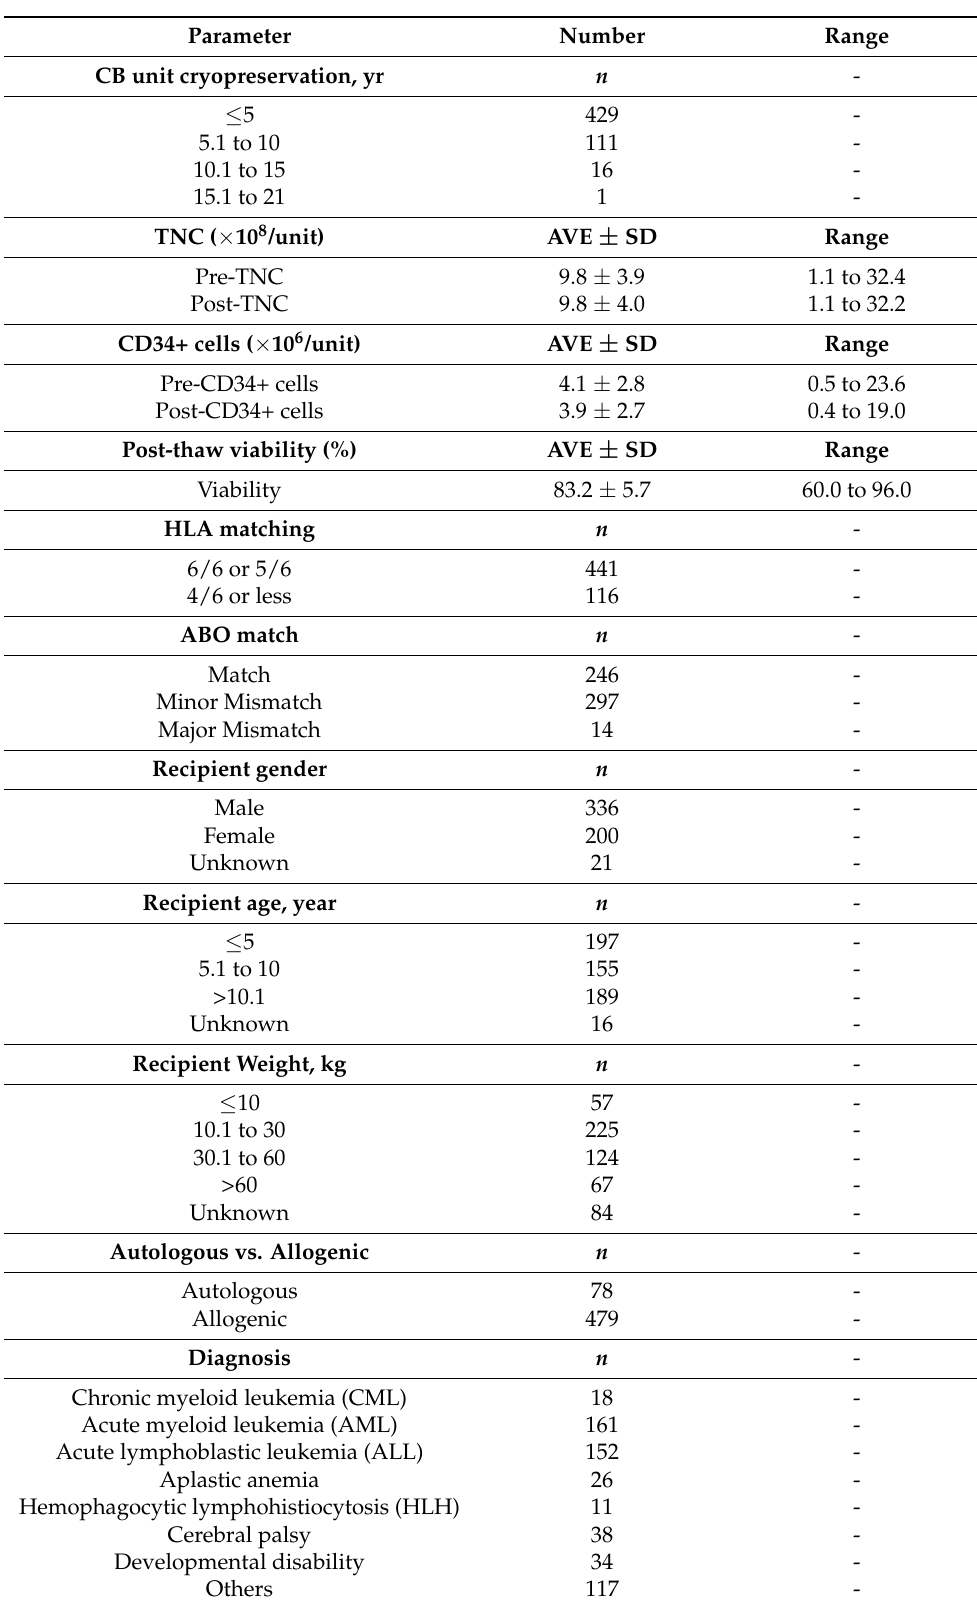
Table 3. Characteristics of 557 patients receiving CB